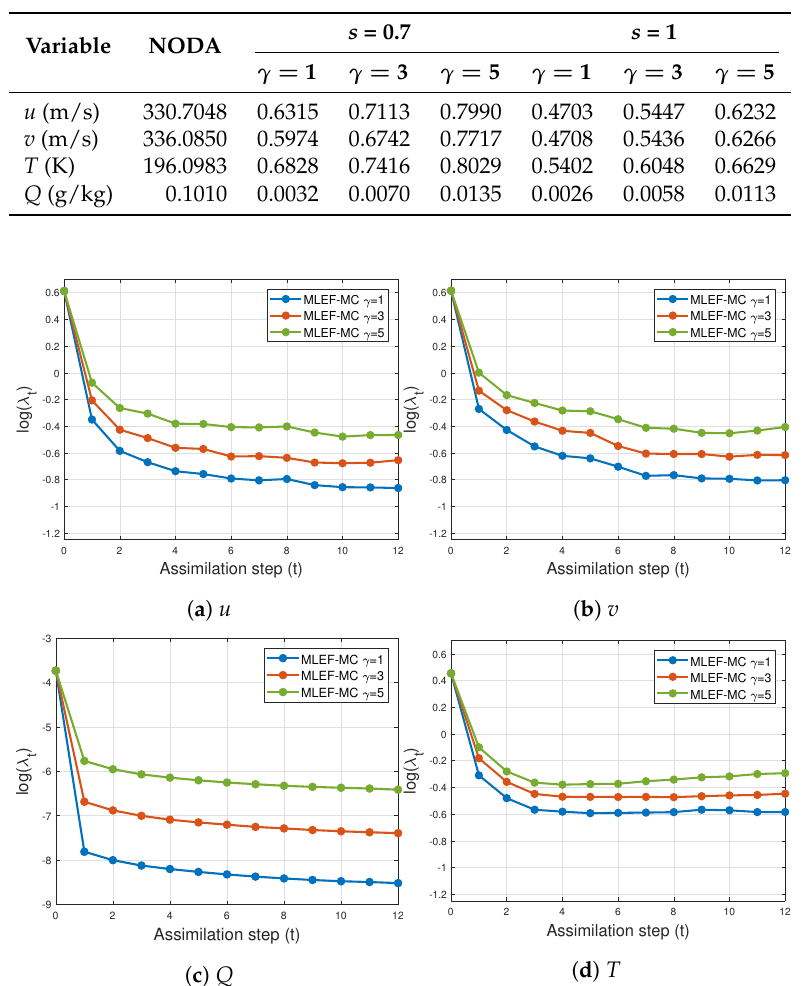
Figure 11. Time evolution of analysis errors for different values of parameters γ and r (MLEF-MC). s = 1 (full observational